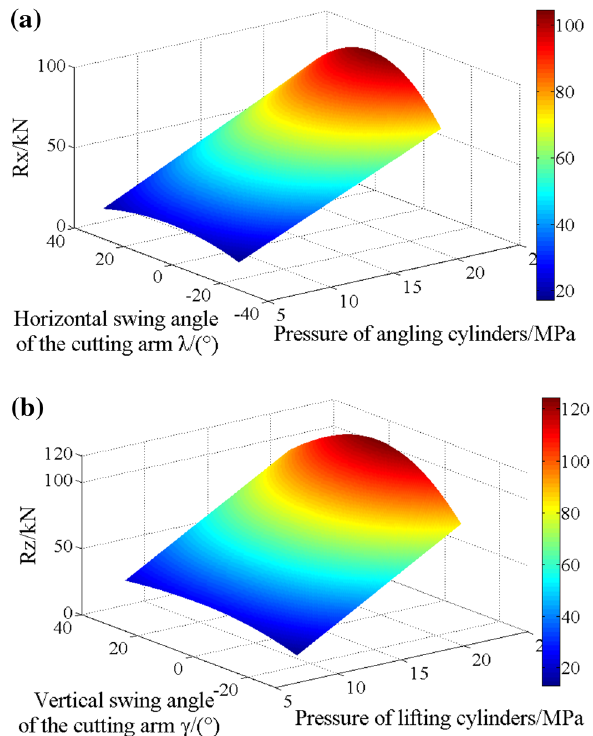
Fig. 7 Calculating results of the cutting load. ( a ) Component force R ; ( b ) Component force R X